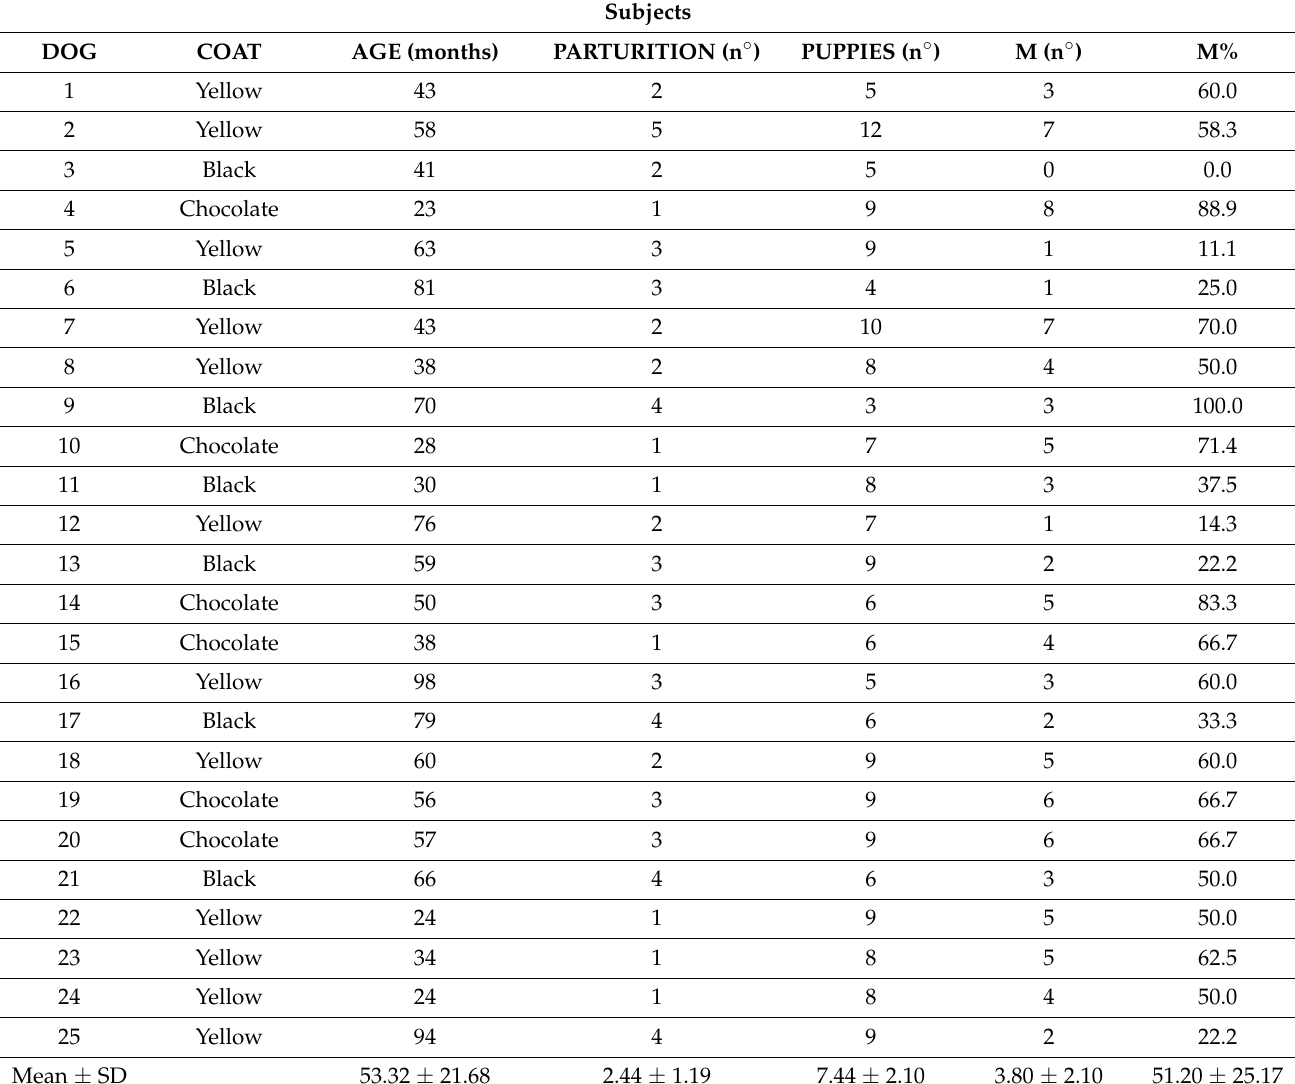
Table 1. Subjects. The coat color, age, number of parturitions, litter size, and number of and percentage of male puppies (M%) of the 25